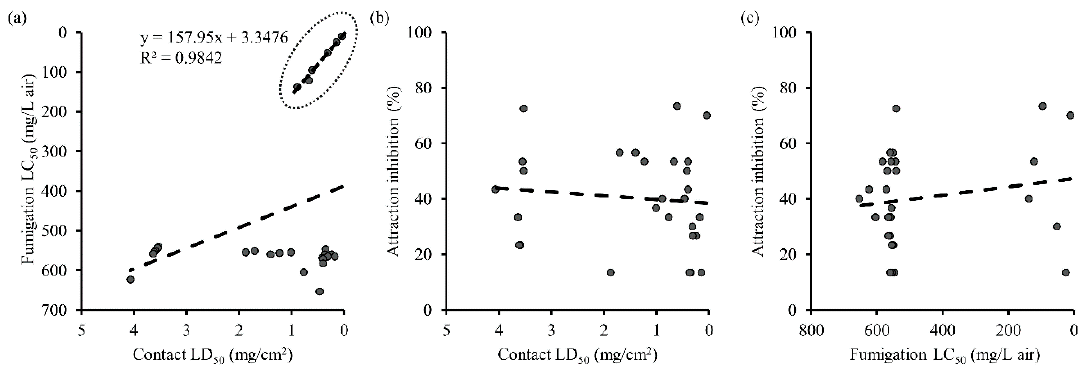
Figure 5. Correlation among contact / residual, fumigation, and anti-attraction activity of 28 essential oils tested: ( a ) contact / residual and fumigation (df = 1, 26; F = 3.60; p = 0.069); ( b ) contact / residual and 1 h attraction inhibition (df = 1, 26; F = 0.28; p = 0.600); ( c ) fumigation and 1 h attraction inhibition (df = 1, 26; F = 0.84; p = 0.367).